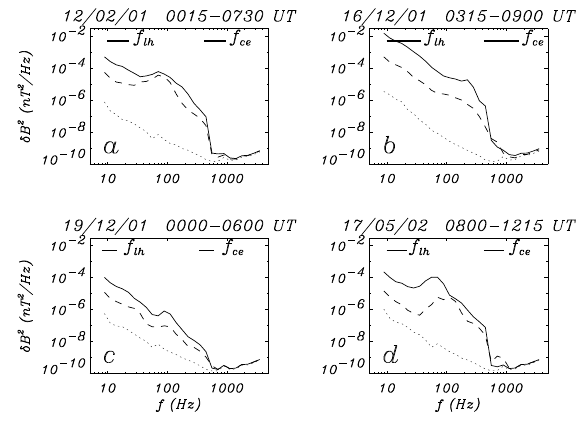
◦ < Θ BV < 2 ( f ) Figure3:Averagepowerspe traldensity δB forlargeangles( 65 115 ◦ ,solidline)andforsmallangles( Θ BV < 25 ◦ , Θ BV > 155 ◦ ,dashedline),for 2 2 Fig. 3. Average power spectral density δB 2 (f ) for large angles Figure2:Day19/12/2001at8.8Hz:a)histogramsof log δB (nT /Hz)forthe thefour onsideredintervals.ThedottedlinegivestheobservedminimumPSD Fig. 2. 19 December 2001 at 8.8Hz: (a) histograms of log δB 2 wholedataset(solidline),andfortheright-handed(cid:29)u tuations(dottedline);b) overea hinterval.Thehorizontalbarsatthetopofea h(cid:28)guregivetherangeof (65 ◦ <2 BV < 115 ◦ , solid line) and for small angles ( 2 BV < 25 ◦ , (nT 2 /Hz) for the whole data set (solid line), and for the right-handed lowerhybridfrequen ies f lh andofele tron y lotronfrequen ies f ce foundduring histogramofthephasedi(cid:27)eren e φ B 1 B 2 betweenthetwo omponents δB 1 and δB 2 B theinterval.3 ofthe(cid:29)u tuationsperpendi ulartothelo al (cid:28)eld(4saverage).Day16/12/2001 2 2 BV > 155 ◦ , dashed line), for the four considered intervals. The fluctuations (dotted line); (b) histogram of the phase difference at70Hz: )histogramof log δB forthewholedataset(solidline),andfor theright-handed(cid:29)u tuations(dottedline);d)histogramofthephasedi(cid:27)eren e φ dotted line gives the observed minimum PSD over each interval. φ B 1 B 2 between the two components δB 1 and δB 2 of the fluctua- B 1 B 2 .2 The horizontal bars at the top of each figure give the range of lower tions perpendicular to the local B field (4 s average). 16 Decem- hybrid frequencies f lh and of electron cyclotron frequencies f ce ber 2001 at 70Hz: (c) histogram of log δB 2 for the whole data set found during the (solid line), and for the right-handed fluctuations (dotted line); (d) histogram of the phase difference φ B 1 B 2 .